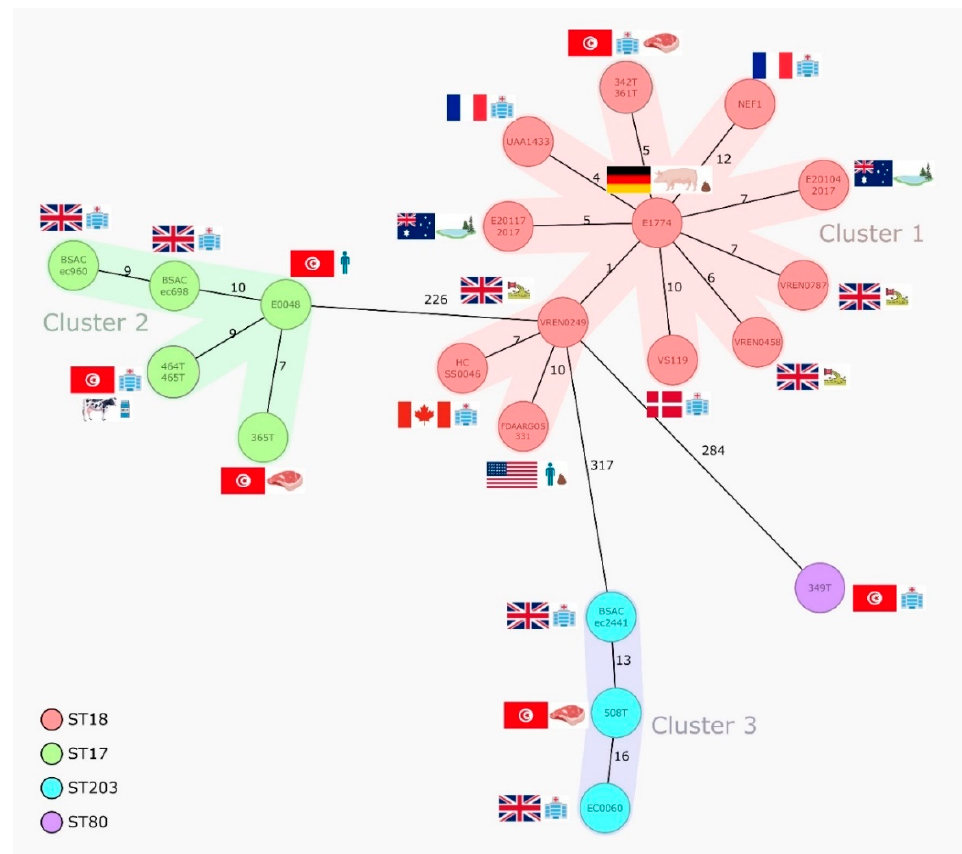
Figure 1. Minimum spanning tree based on the cgMLST data from E. faecium isolates ( n = 24) of different sources. The tree is based on cgMLST (1423 genes) analyses made with SeqSphere + software. Each circle represents one allele profile. The numbers on the connecting lines represent the number of cgMLST allelic differences between two isolates. STs are shown in coloured circles (see legend). Colour shading around nodes indicates clusters of closely related isolates ( ≤ 20 SNPs).